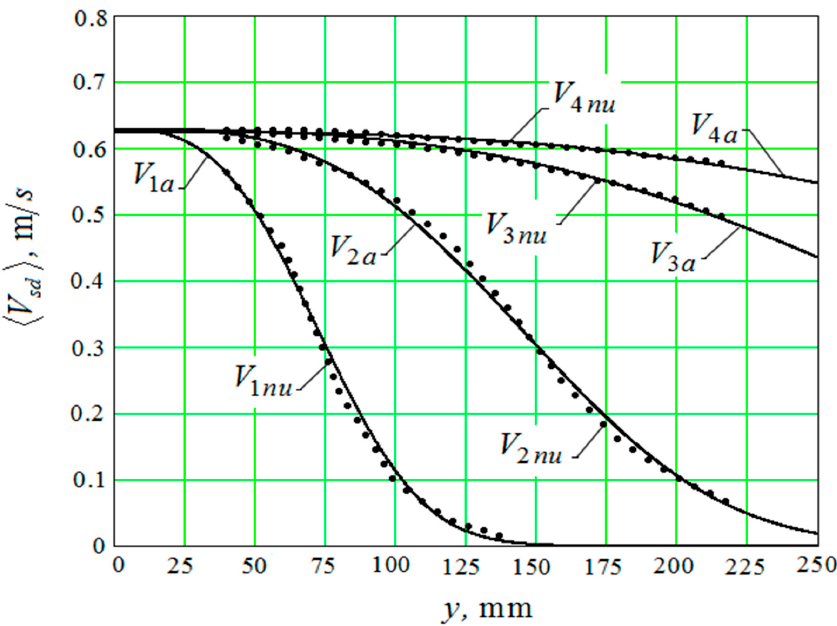
Materials 2019 , 12 , x FOR PEER REVIEW Figure 4. The results of the numerical solution of Equation (41). Figure 4. The results of the numerical solution of Equation (41).